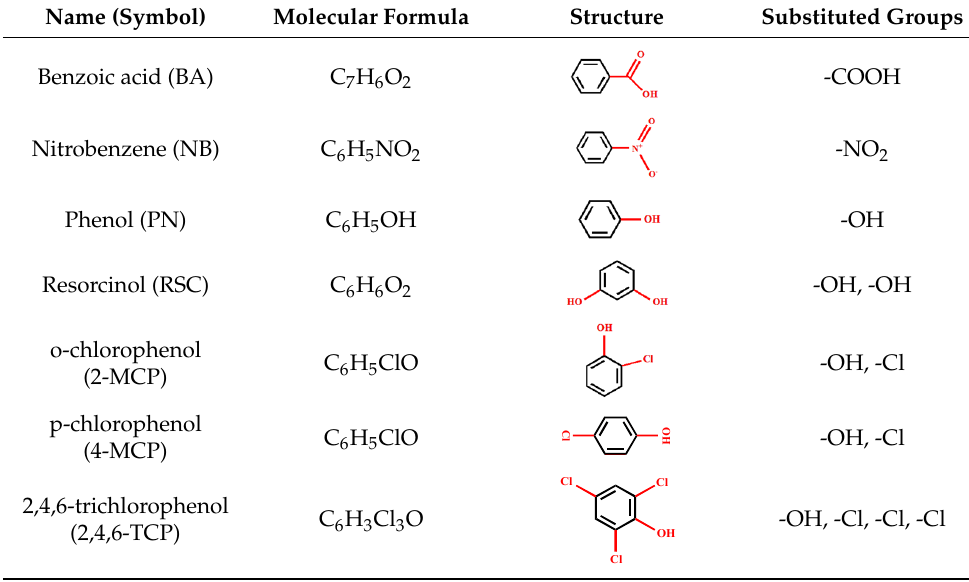
Table 1. List of seven benzene derivatives as model precursors. Molecular Name (Symbol) Structure Substituted Groups Formula